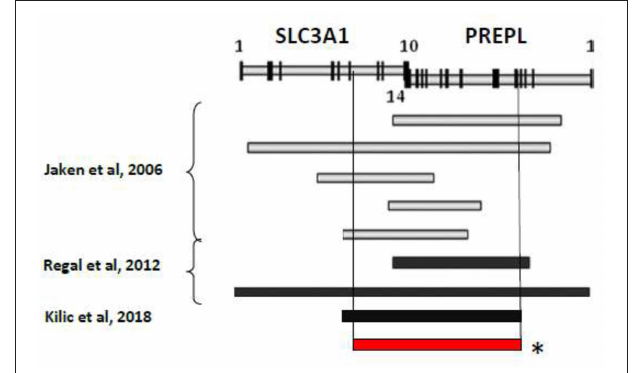
FIGURE 1 | Summary of reported deletion in the 2p21 associated to HCS. *Genetic mutation of the described patient.